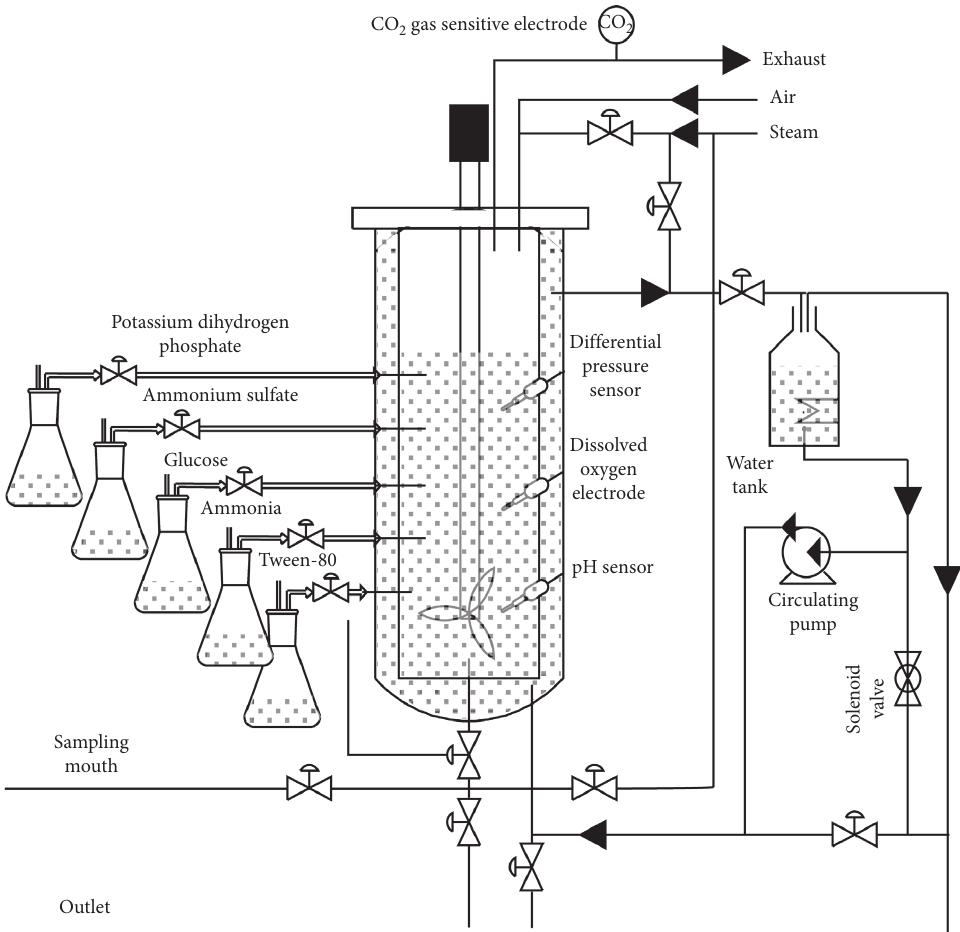
Figure 3: Technological process of marine protease fermentation